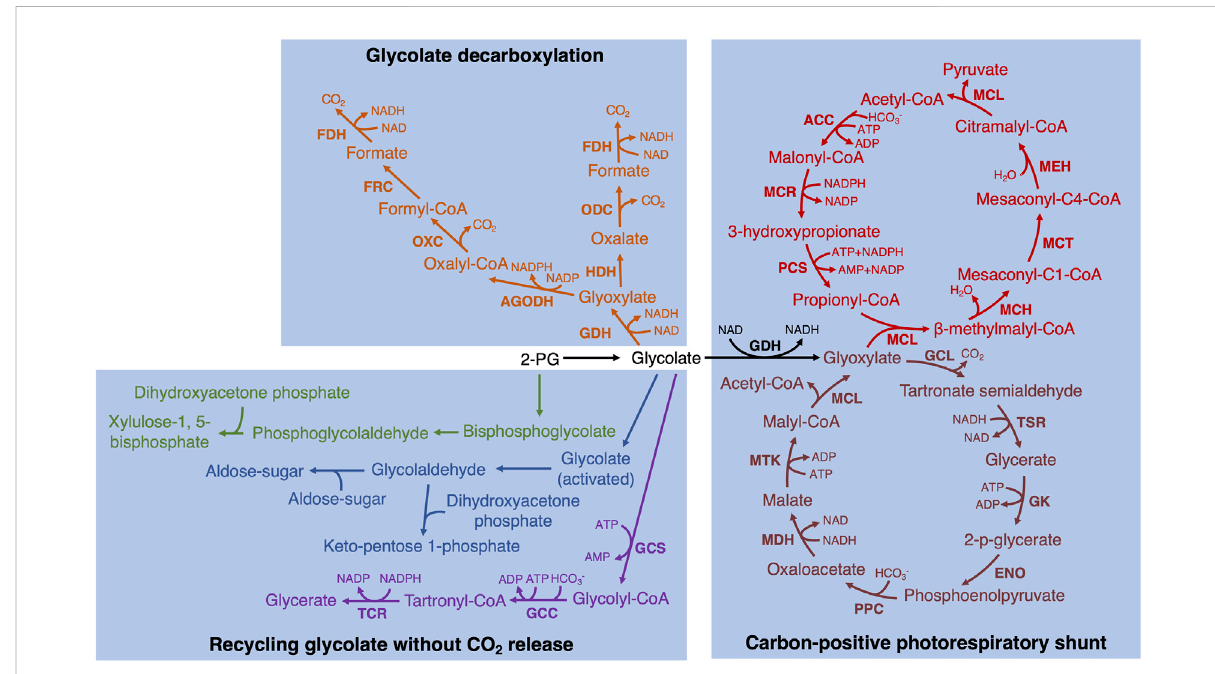
FIGURE 2 The potentially achieved biosynthetic bypasses of photorespiration in plants. Two glycolate decarboxylation bypasses are marked by orange (Eisenhutetal.,2008;Claassensetal.,2020;Khurshidetal.,2020).GDH,glycolatedehydrogenase;HDH,hydroxyaciddehydrogenase;ODC,oxalate decarboxylase; FDH, formate dehydrogenase; AGODH, CoA-acylating glyoxylate dehydrogenase; OXC, oxalyl-CoA decarboxylase; FRC, formyl- CoA transferase. Two different hypothetical bypasses to recycle glycolate without CO 2 release are marked by green (Ort et al., 2015) and blue (Bar-Even,2018),respectively.Tartronyl-CoApathway(purple;Scheffenetal.,2021):GCS,glycolyl-CoAsynthetase;GCC,glycolyl-CoAcarboxylase; TCR, tartronyl-CoA reductase. The bypass converting glycolate to pyruvate (black and red; Shih et al., 2014): MCL, malyl-CoA lyase; MCH, mesaconyl-C1-CoA hydratase; MCT, mesaconyl-CoA C1:C4 CoA transferase; MEH, mesaconyl-C4-CoA hydratase; ACC, acetyl-CoA carboxylase; MCR, malonyl-CoA reductase; PCS, propionyl-CoA synthase. The bypass converting glycolate to acetyl-CoA (black and dark red; Yu et al., 2018): GCL, glyoxylate carboligase; TSR, tartronic semialdehyde reductase; GK, glycerate kinase; ENO, enolase; PPC, phosphoenolpyruvate carboxylase; MDH, malate dehydrogenase; MTK, malate